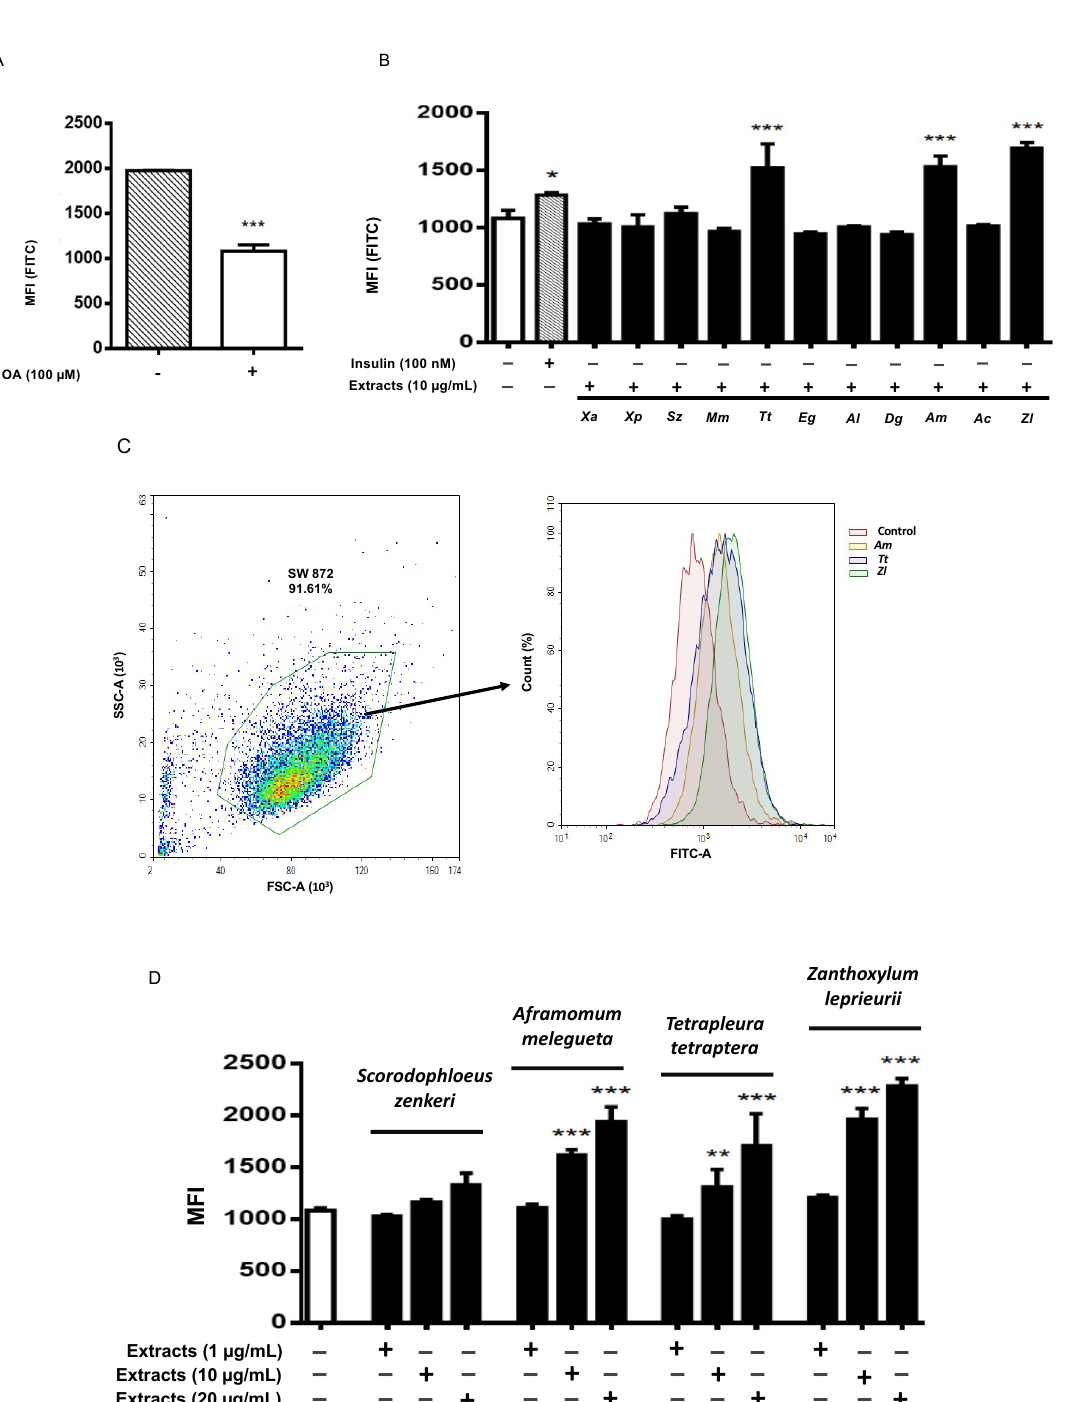
Figure 2. Glucose uptake in SW 872 cells treated with spice extracts. ( A ) Basal glucose uptake in non-differentiated and differentiated cells (100 µ M OA); *** p < 0.001 (unpaired t -test). ( B ) Differentiated cells were incubated for 1 h with 100 nM insulin or treated for 24 h with 10 µ g/mL of each spice extract. Xa , Xylopia aethiopica ; Xp , Xylopia parviflora ; Sz , Scorodophloeus zenkeri ; Mm , Monodora myristica ; Tt , Tetrapleura tetraptera ; Eg , Echinops giganteus ; Al , Afrostyrax lepidophyllus ; Dg , Dichrostachys glomerata ; Am , Aframomum melegueta ; Ac , Aframomum citratum ; Zl , Zanthoxylum leprieurii . * p < 0.05, *** p < 0.001. ( C ) Mean fluorescence intensity (MFI) of FACS analysis obtained in differentiated SW 872 cells by treatment with Aframomum melegueta ( Am ), Zanthoxylum leprieurii ( Zl ) and Tetrapleura tetraptera ( Tt ). The control (red area) is represented by differentiated SW 872 cells MFI. ( D ) Differentiated cells were treated for 24 h with the indicated extracts at 1–10–20 µ g/mL. Glucose uptake was assessed in SW 872 cells by FACS analysis. One experiment ( n = 3) is shown as representative of 3 separated experiments, each in triplicate. Results are expressed as mean ± SD. ** p < 0.01, *** p < 0.001 (one-way ANOVA multiple